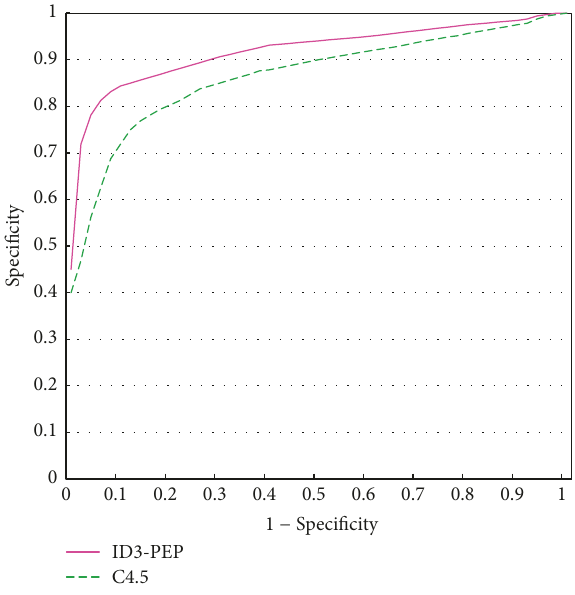
Figure 6: The comparison of ID3-PEP and